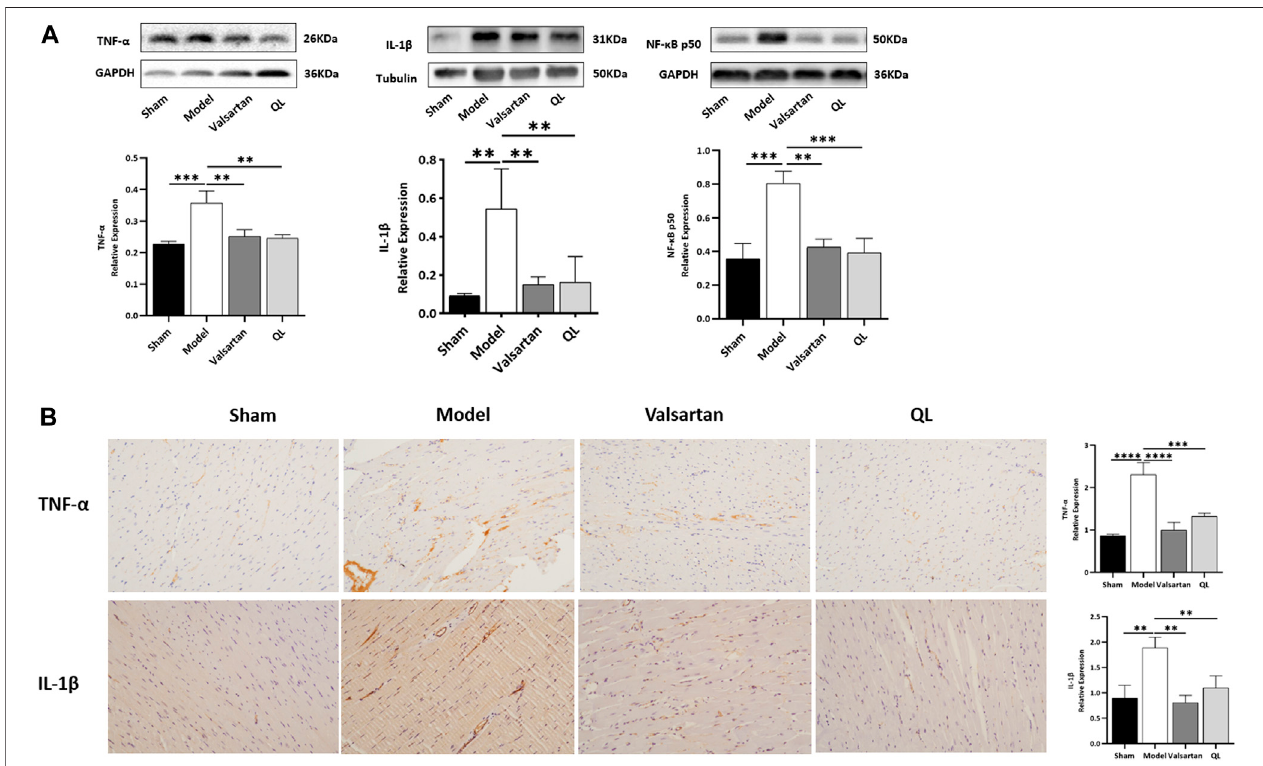
FIGURE 5 | QL suppresses IL-1 β , NF- κ B, and TNF- α expression. (A) Western blot analysis of IL-1 β , TNF- α , and NF- κ B p50 expression in the cardiac tissue. (B) Relative expression of TNF- α and IL-1 β in the heart detected through immunohistochemical analyses. GAPDH or tubulin was detected as the loading control. IL-1 β : interleukin1 β ,NF- κ B:nuclearfactor kappa B,and TNF- α : tumor necrosisfactor- α .The dataarethemean ±standard deviation ( (cid:1) x ± s ) (n=3or 4per group); ** p < 0.01, *** p < 0.001, and **** p < 0.0001.